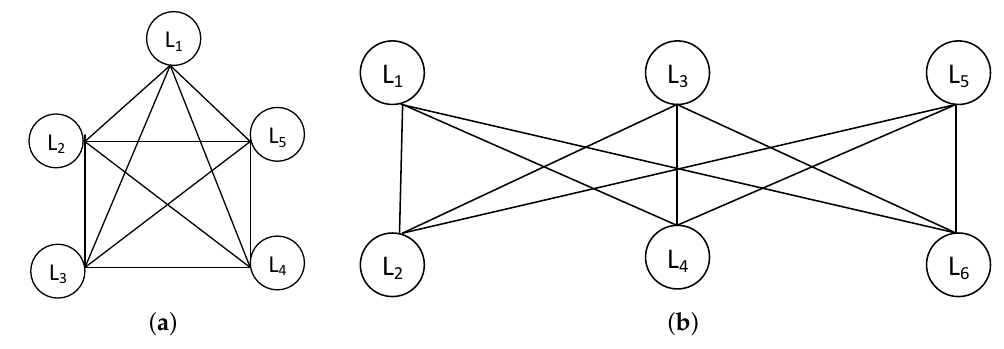
Figure 6. Illustration of ( a ) K 5 and ( b ) K 3,3